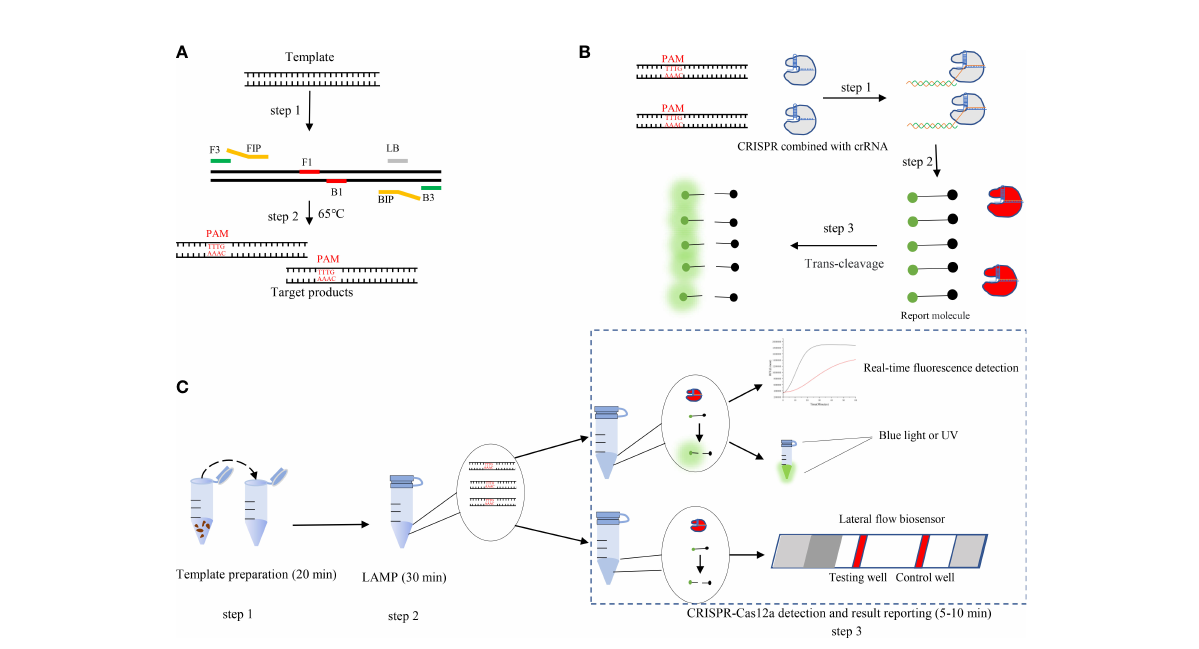
FIGURE 1 (A) Schematic illustration of loop-mediated isothermal ampli fi cation (LAMP). (B) Schematic illustration of CRISPR-Cas12a detection. Step 1: LAMP products are obtained. Protospacer adjacent motif (PAM) sites guide the CRISPR/Cas12a-gRNA complex to recognize target sites. Step 2: Cas12a effectors are activated. Step 3: The activated effectors nonspeci fi cally cleave single-stranded DNA reporter molecules by trans-cleavage. (C) Schematic illustration of the LAMP-CRISPR/Cas12a assay work fl ow. The LAMP-CRISPR/Cas12a assay involves three closely linked steps: